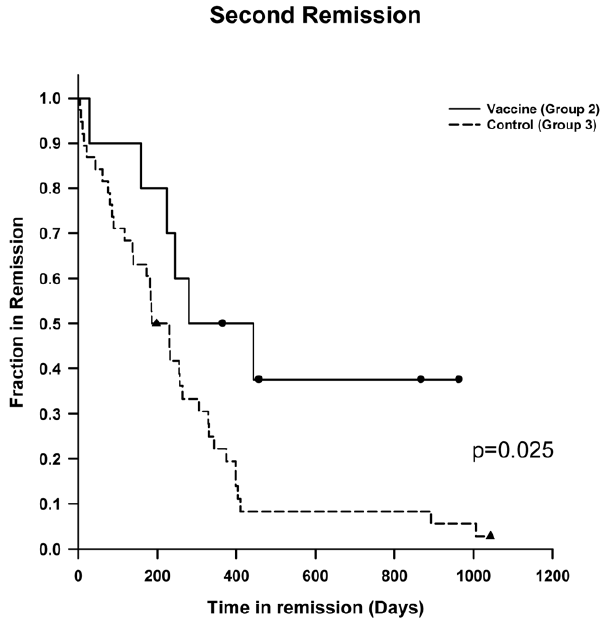
Figure 3. Kaplan Meier estimates for lymphoma-specific survival (LSS) of relapsed dogs who received salvage therapy, demonstrating statistically significant differences between vaccinated Group 2 to unvaccinated control Group 3 (p=0.038).